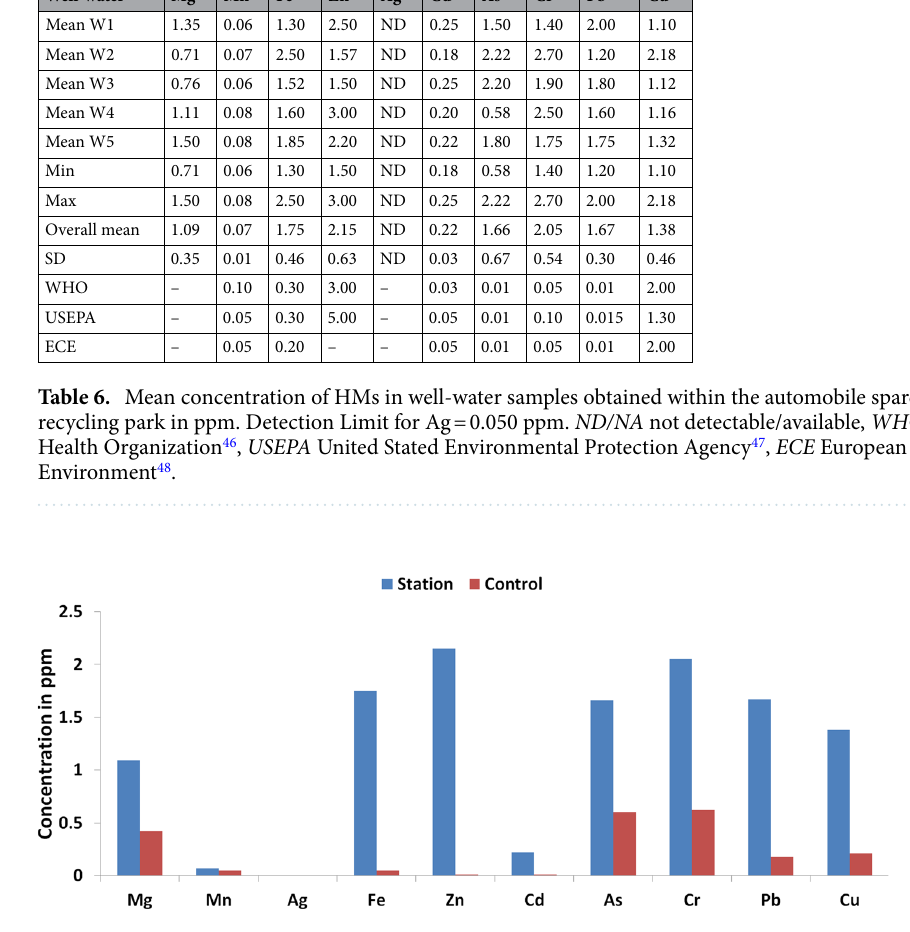
Figure 2. Graph of the mean concentration of heavy metals in the top soil within the automobile station and control